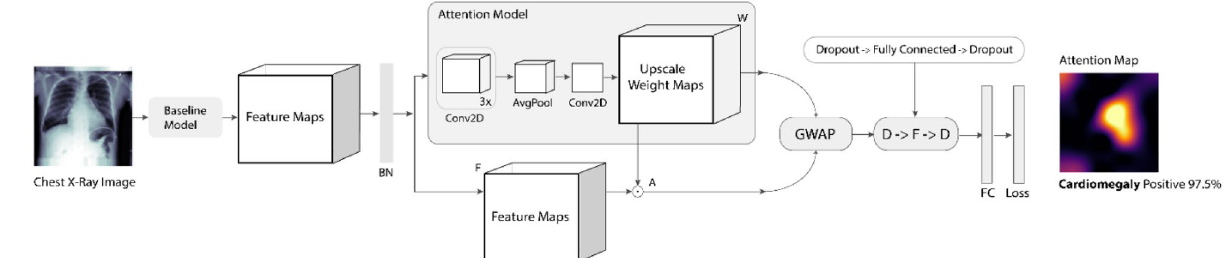
Figure 4. The network architecture of the Attention Mapping Mechanism (AMM) where BN, F, W and A represent Batch Normalization, output feature maps of the base model, learned weight maps of the attention model and weighted feature maps respectively. GWAP represent the Global Weighted Average Pooling operation that perform on weighted feature maps (A) and learned weight maps (W). Layers with concerned filter sizes of the AMM are demonstrated in Table